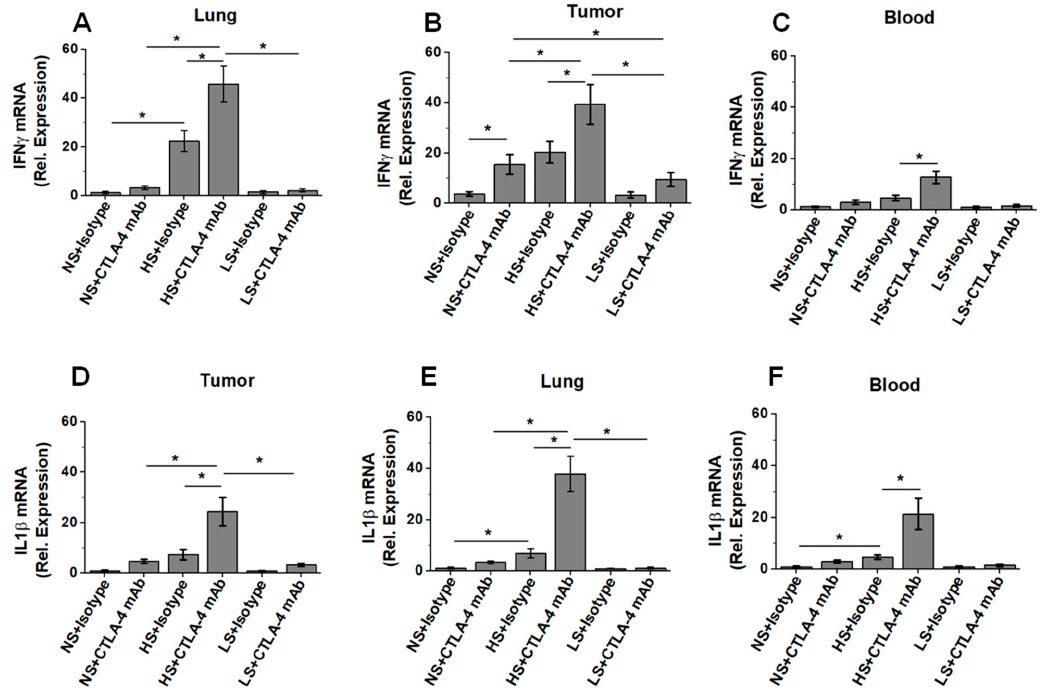
Figure 4. Low-salt diet reduces systemic irAE response in breast-tumor-bearing mice. The mRNA expression of inflammatory cytokines in CD4+T cells were analyzed in tumor-infiltrating, lung-infiltrating and peripheral circulation of breast tumor-bearing mice on ICI therapy following salt diet modification. ( A – C ) The mRNA expression of IFN γ in CD4+T cells isolated from tumor ( A ), lung ( B ) and blood ( C ) in NS, HS and LS diet cohorts following treatment with anti-CTLA4 mAb or isotype control. ( D – F ) The mRNA expression of IL-1 β in CD4+T cells isolated from tumor ( D ), lung ( E ) and blood ( F ) in NS, HS and LS diet cohorts following treatment with anti-CTLA4 mAb or isotype control. Data analyzed by one-way ANOVA for multiple comparisons; data presented as mean ± SEM, n = 8 (biological replicates) per cohort, (*) p -value <